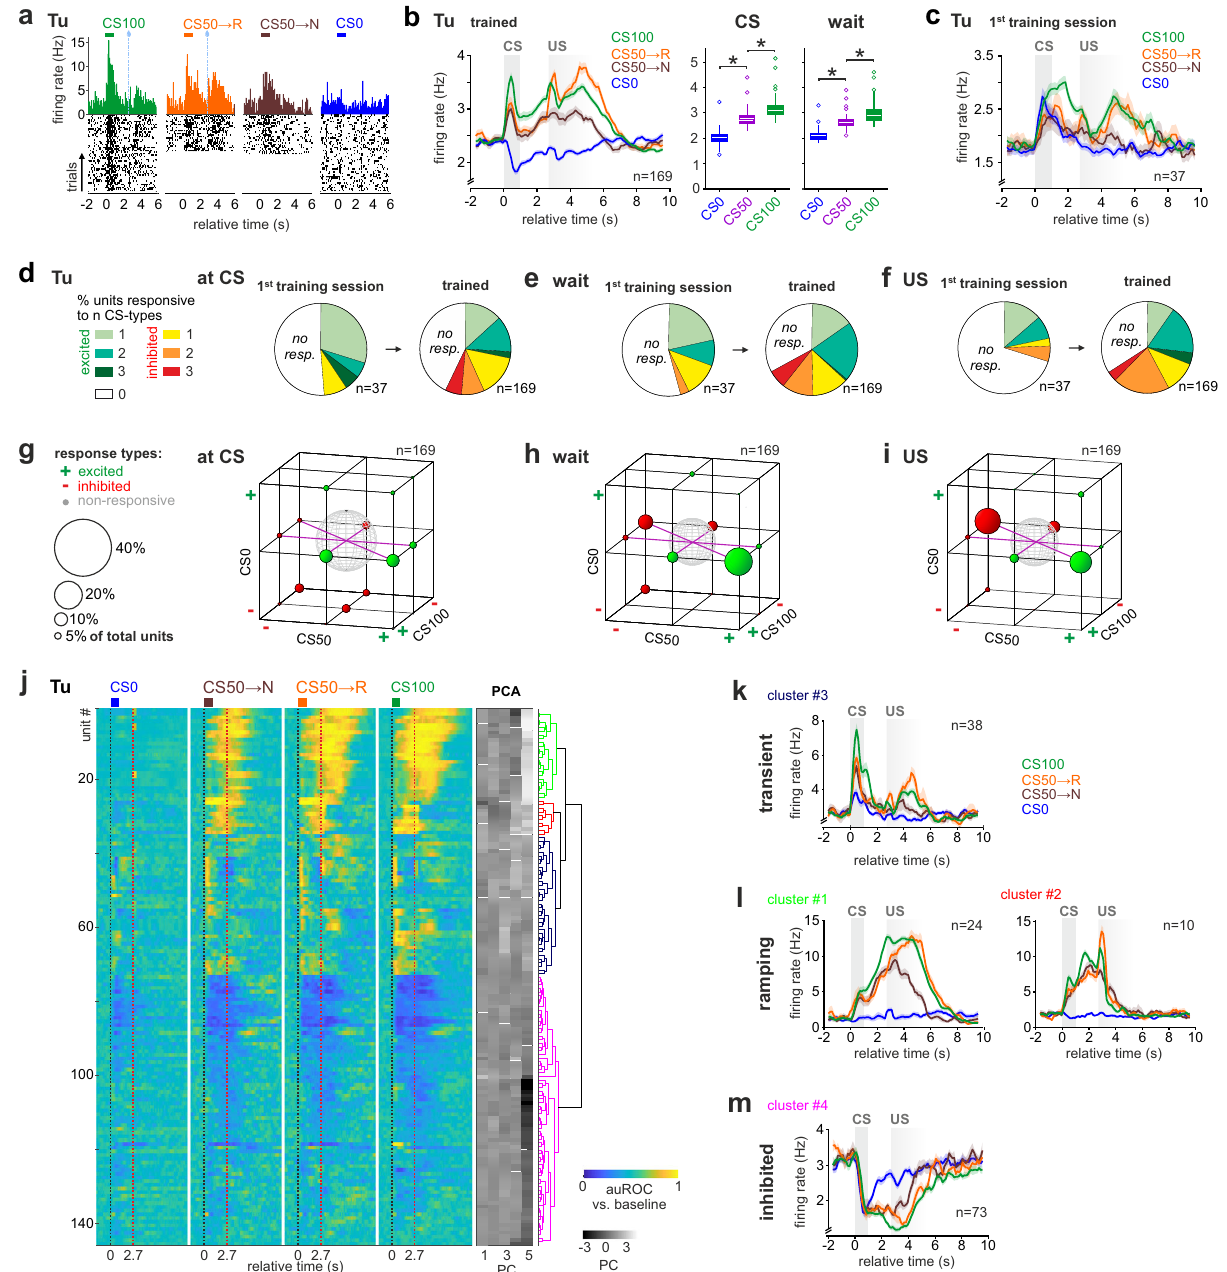
Fig. 7 Tu units form transient and ramping task-response clusters. a – c Same as Fig. 6a – c for Tu. After training, the task-related mean fi ring rate evolution ± SEM in Tu units re fl ected monotonic RP and reward surprise ( n = 169 units). The bounds of the boxes represent 25th to 75th percentiles. The center indicates the median. The lower and upper whiskers represent the minimum and maximum values without outliers; outliers indicated by circles. * indicates P < 0.05 (see Supplementary Table 1 for exact P values and test details). Source data are provided as a Source Data fi le. d – f Fraction of single units showing signi fi cant task-excited, task-inhibited or no responses to either one or more trial types (CS0, CS50, CS100) at CS ( d ), during wait ( e ), and at US ( f ). Of note, the fraction of single units responsive to more than one trial type increased with training. g – i Fractions of selective and shared unit responses to different trial types ( g ) at CS, ( h ) during wait, and ( i ) at US in the Tu. The size of the spheres corresponds to the respective fraction of units. Green color indicates task-excited responses ( + ), while red color stands for task-inhibited responses ( – ). Note the shared coding of rewarded trial types during wait and at US. j Same as Fig. 6g for Tu. In the Tu, PCA-based hierarchical clustering revealed four task-response clusters. k – m Same as Fig. 6h – j for Tu. Mean fi ring rate ± SEM for each cluster identi fi ed in ( j ). According to their responsiveness at CS and during wait, single units were grouped into three functional clusters composed of units with ( k ) task-excited, transient activity at CS, ( l ) task-excited, ramping activity during waiting, and ( m ) task-inhibited responses. Both the transient- and ramping clusters displayed a monotonic RP (see Supplementary Fig. 8d – f). n indicates the number of